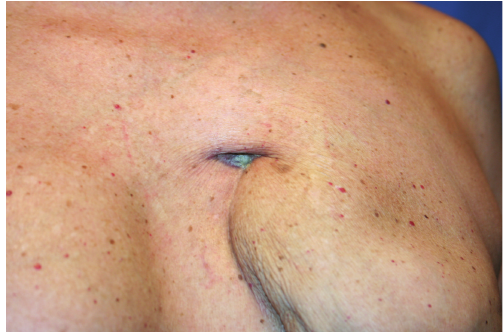
Figure 2: Breast fistula before fat graft (detail).